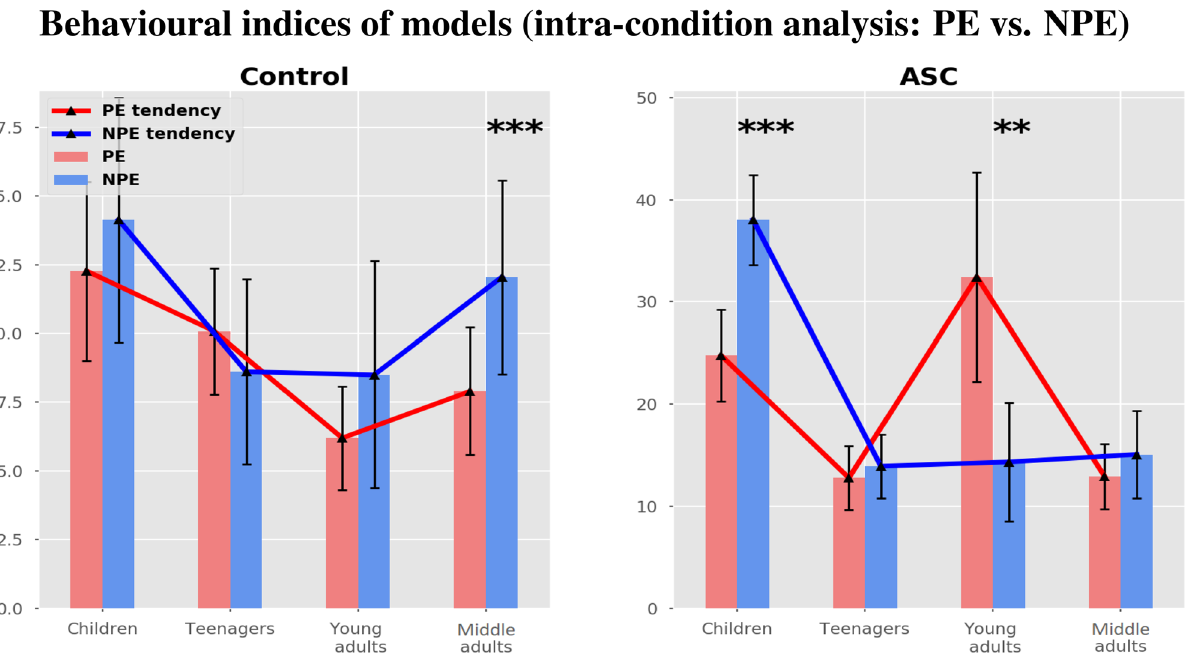
Figure 3. Comparisons between PE and NPE in the control and ASC conditions (Children, Teenagers, Young adults, Middle